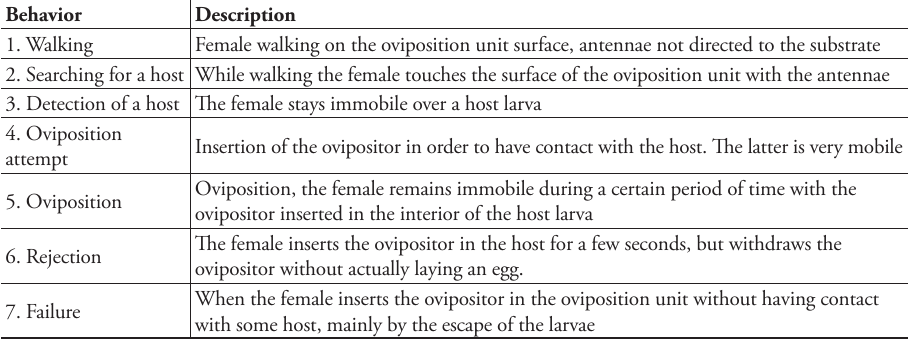
Table 1. Definitions of the different behaviors exhibited by Utetes anastrephae , Doryctobracon crawfordi and Opius hirtus while foraging for host larvae.